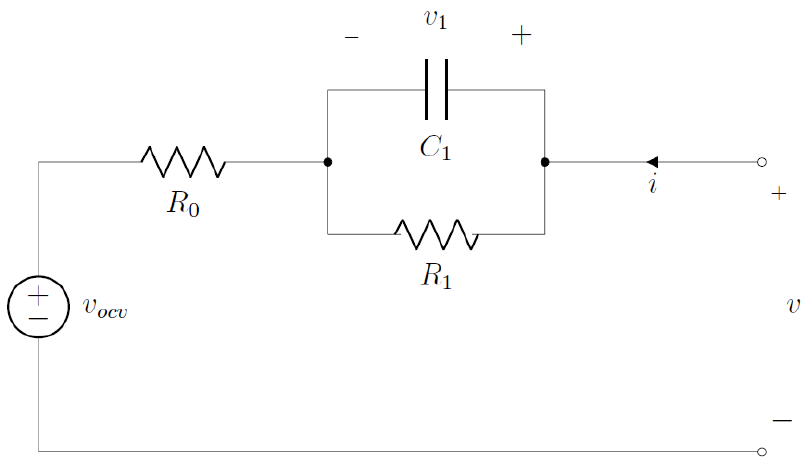
Figure 3. Schematics of Extended Equivalent Circuit Model (XECM)